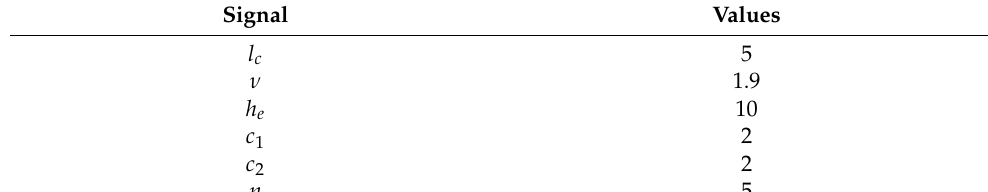
Table 2. Design parameters of control laws.